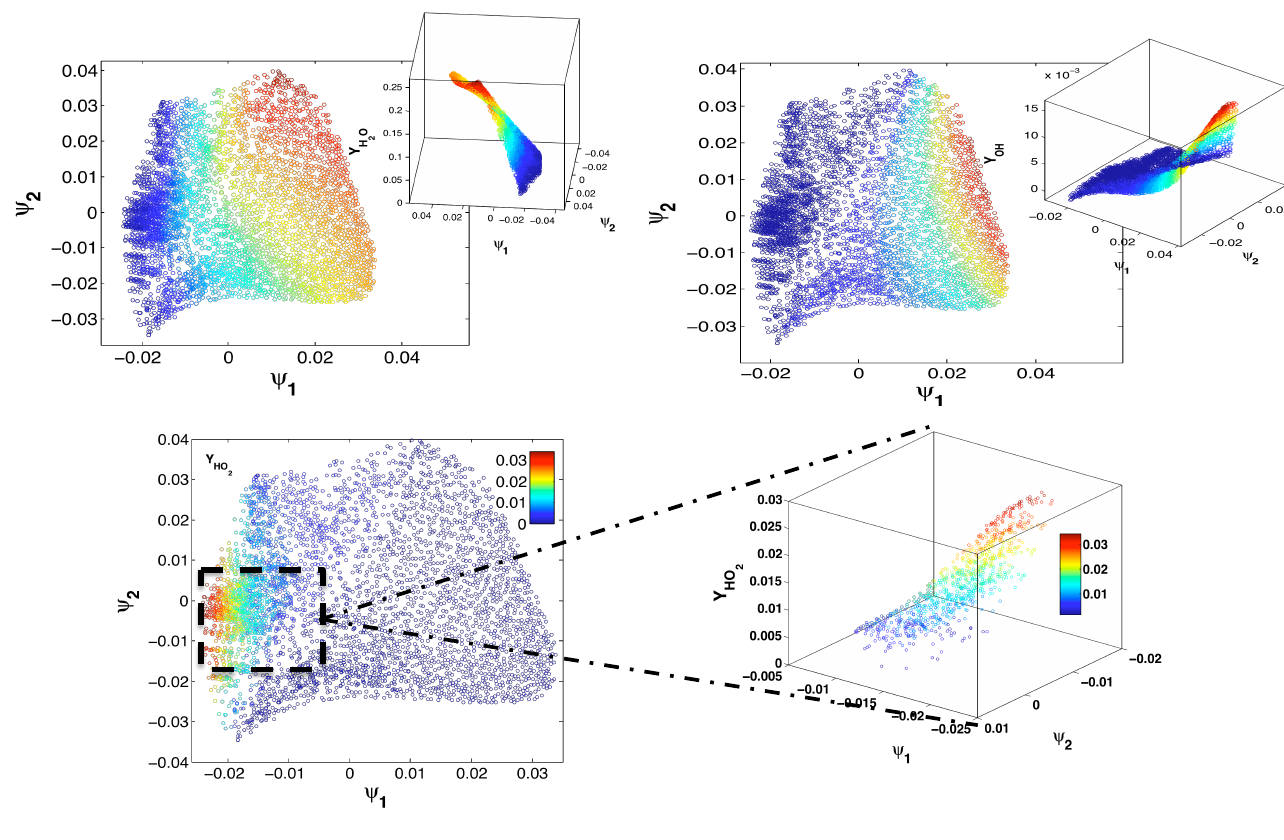
− ψ Figure 10. ( Top ) Projection of the manifold onto the ψ plane, where colors refer to the 2 3 O ( left-hand side ) and OH ( right-hand side ). From the three dimen- mass fraction of H 2 sional views reported in the insets, we can infer that a two-dimensional reduced description is − ψ suitable for most of the domain. ( Bottom ) Projection of the manifold onto the ψ plane, 2 3 where colors refer to the mass fraction of HO ( left-hand side ). A three-dimensional view 2 ( right-hand side ) highlights that in the zoomed region, a higher dimensional description is